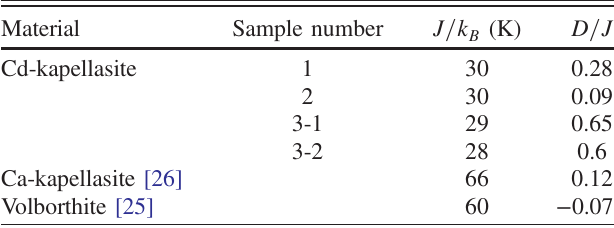
TABLE I. Values of J and j D=J j used to fit κ 2 D simulation (Fig. 10) for kagome lattice antiferromagnets. The data of Ca-K and those of volborthite are taken from Refs. [26,25], respectively.